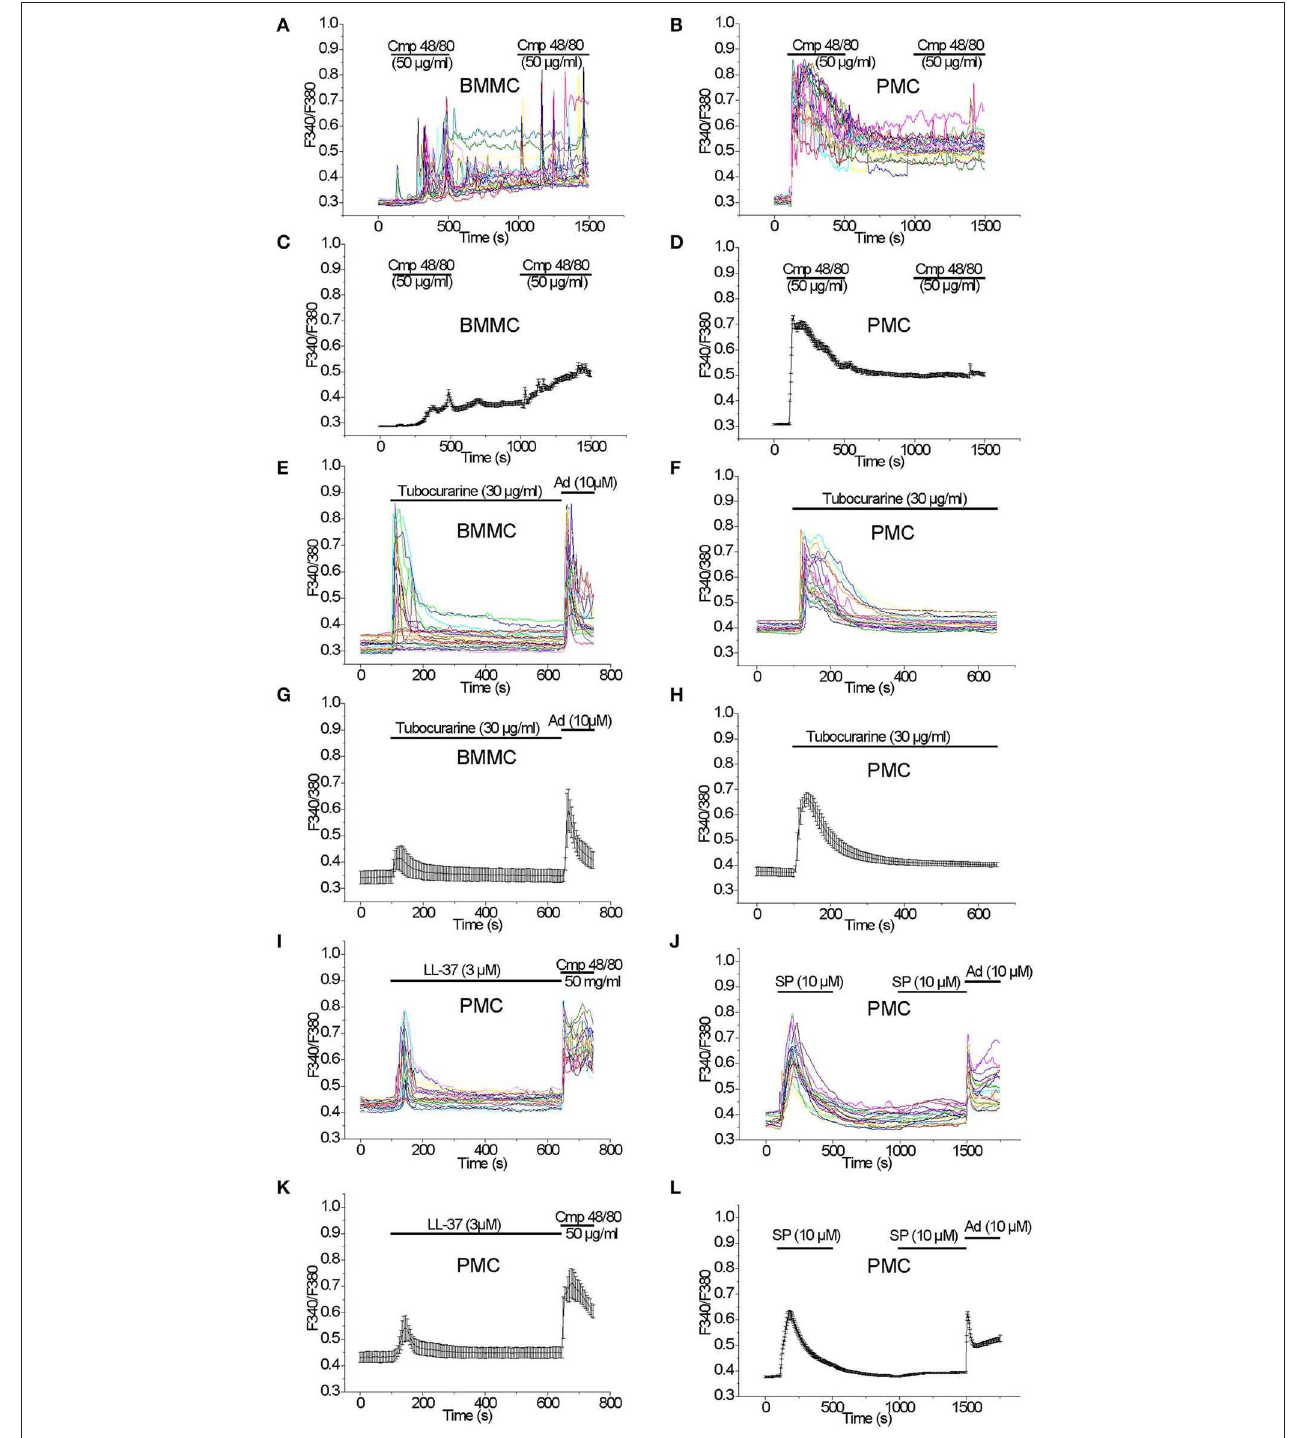
FIGURE 2 | [Ca 2 + ] i rise induced by Mrgprb2 agonists in BMMC and PMC. Measurements of [Ca 2 + ] i changes performed with Fura-2 and presented as F340/F380 fluorescence ratio in BMMC (A,C,E,G) and PMC (B,D,F,H–L) isolated from WT mice. Representative traces ( n = 20 each panel) of [Ca 2 + ] i changes (error bars indicate S.E.M.) induced by application of: 50 µ g/ml Compound 48/80 (A–D) , 30 µ g/ml Tubocurarine (E–H) , 3 µ M LL-37 (I,K) , 10 µ M Substance P (J,L) . The measurements were performed in 3–5 independent cell preparations. At the end of recordings, control reactions were elicited by application of 10 µ M adenosine “Ad” (E,G,J,L) or by application of 50 µ M Compound 48/80 “Cmp” (I,K)